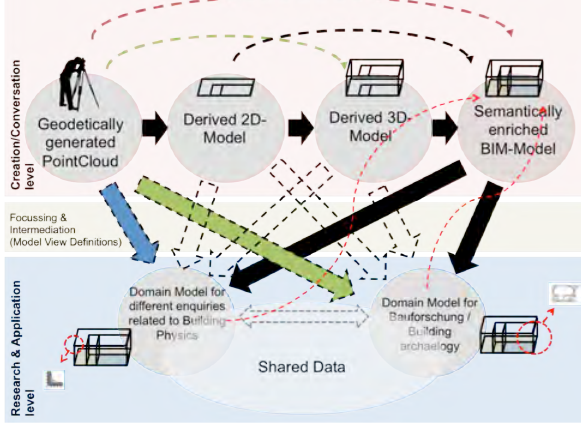
Figure 7: Data acquisition and processing concept and principle conversion to specialized domain